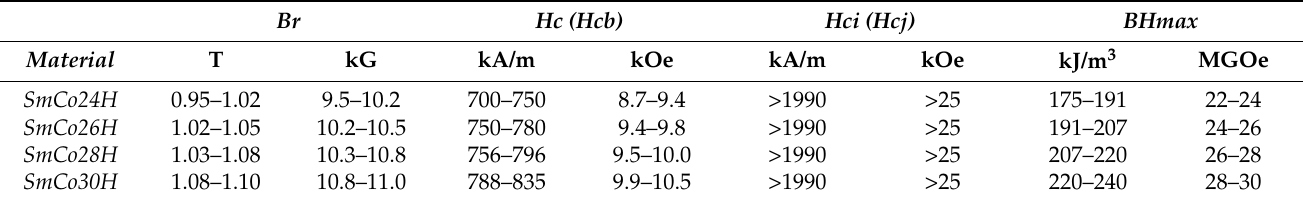
Table 2. Typical range of Sm2Co17 (2:17 alloy)